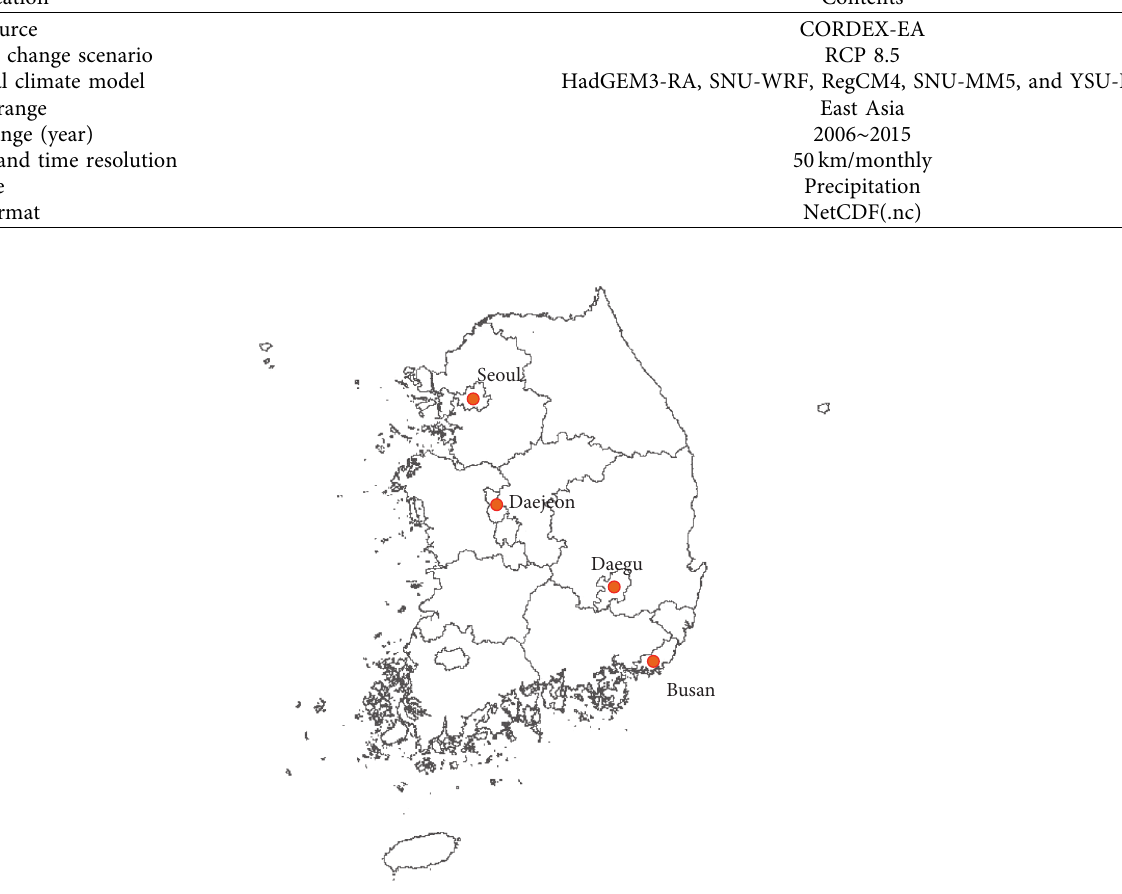
Figure 2: Locations of 4 major cities in Korea.